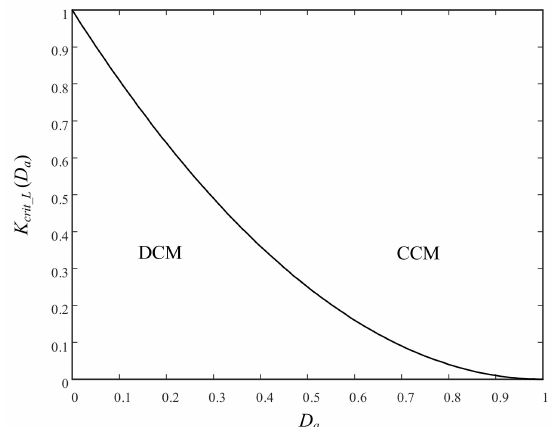
Figure 11. Boundary curve between CCM and DCM for L